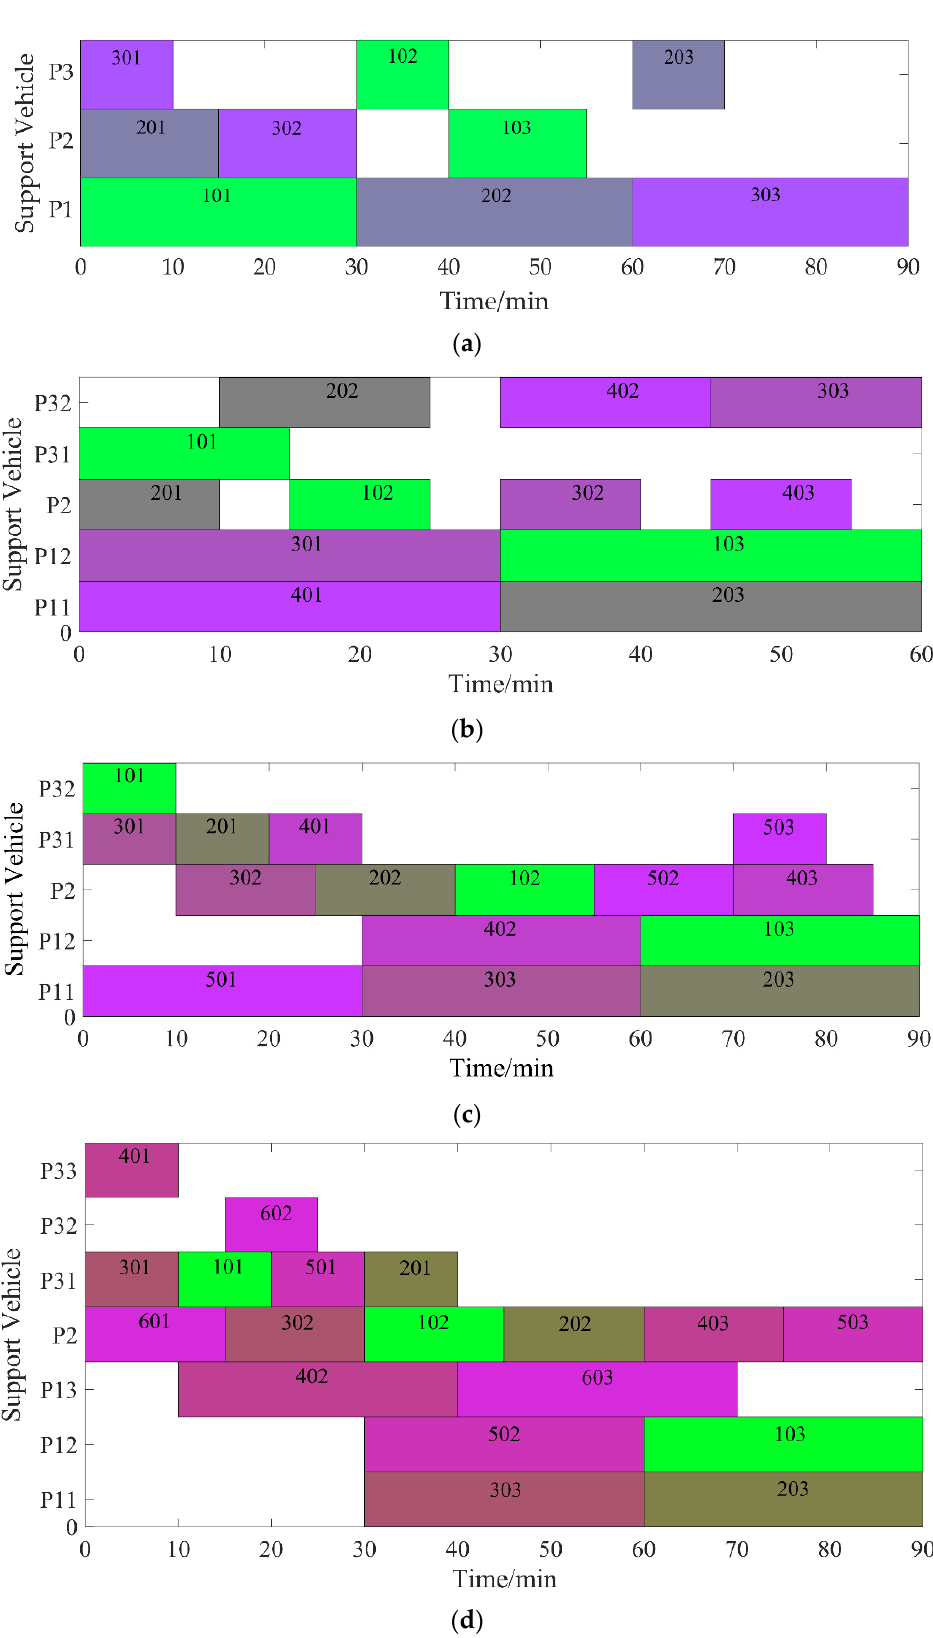
Figure 5. Change of population fitness value. ( a ) 3 aircraft, ( b ) 4 aircraft, ( c ) 5 aircraft, ( d ) 6 aircraft.